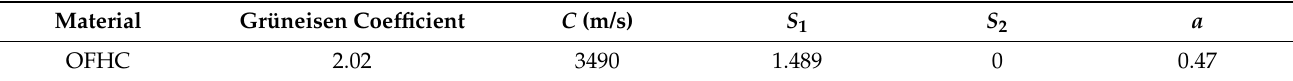
Table 4. EOS parameters of the copper